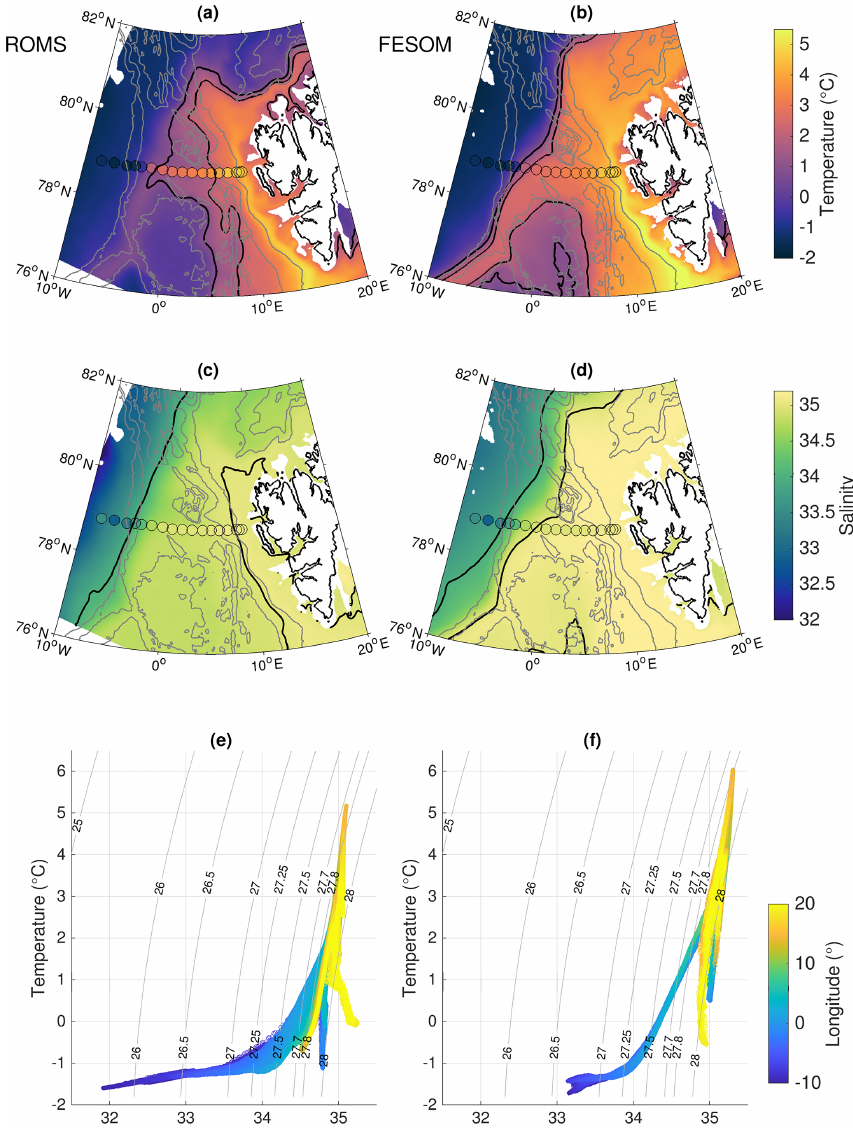
Figure 3. Temperature (a, b) and salinity (c, d) at a depth of 100m averaged over the time period 2006–2009 simulated by ROMS (a, c) and FESOM (b, d) . Black contour lines show the 1 and 2 ◦ C isotherms and the 34 and 35 isohalines. Dots show mooring measurements at a depth of 75m for the same time period (von Appen et al., 2019). Grey contour lines indicate bathymetry at 1000m intervals. T/S diagram of simulated temperature and salinity at a depth of 100m in the region 10 ◦ W–20 ◦ E, 76–82 ◦ N in ROMS (e) and FESOM (f) . The colour shading indicates the longitude of data